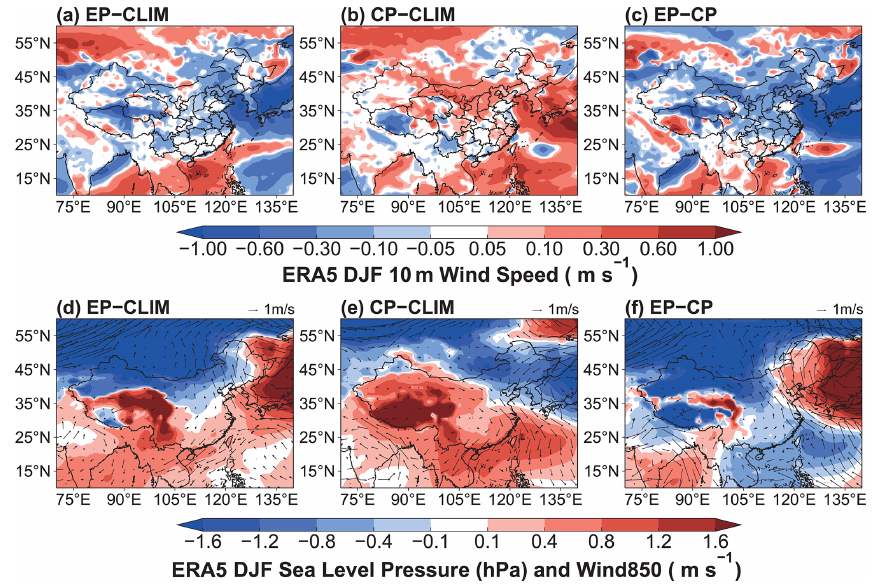
Figure 5. Composite differences in DJF mean 10m wind speed (ms − 1 ) (a–c) and sea level pressure (SLP; shaded; units: hPa) and wind at 850hPa (WIND850; vector; units:ms − 1 ) (d–f) between 2006/07 EP El Niño and climatological mean (1950–2017) in (a) and (d) , 2014/15 CP El Niño and climatological mean in (b) and (e) , and 2006/07 EP El Niño and 2014/15 CP El Niño in (c) and (f) from the EAR5 reanalysis data. The data were detrended over